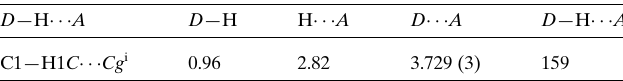
Table 1 Hydrogen-bond geometry (A˚ , (cid:2) ). Cg is the centroid of the C2–C7 ring.